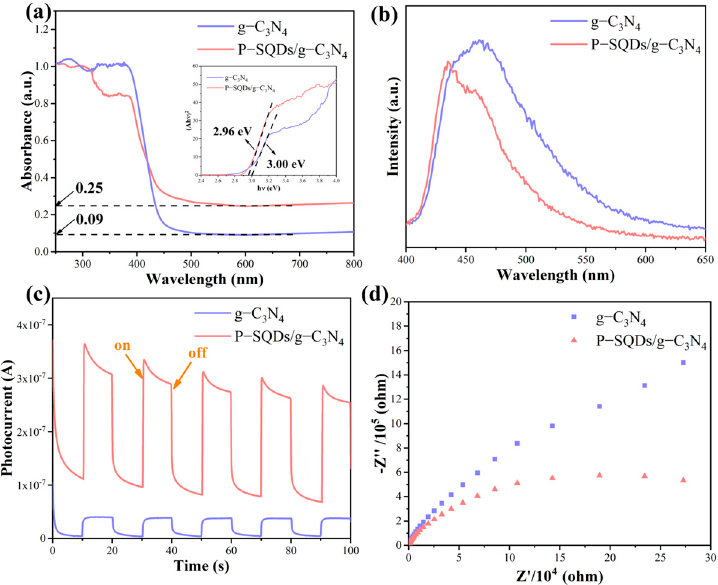
Figure 5. The comparation of P-SQDs/g-C 3 N 4 and g-C 3 N 4 . ( a ) UV–vis absorption spectra (the insert are band gap simulations using Tauc function). ( b ) Steady-state PL spectra. ( c ) Transient photocurrent curves. ( d ) EIS.